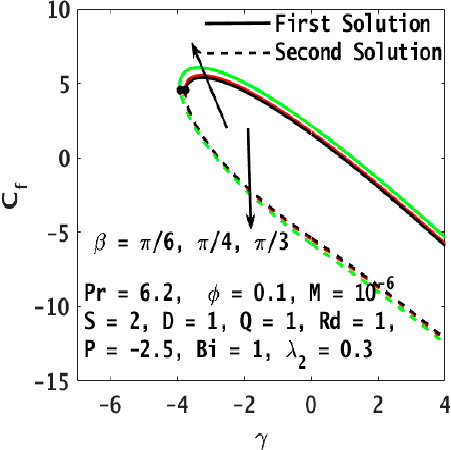
Figure 4. Variation of C f with β .